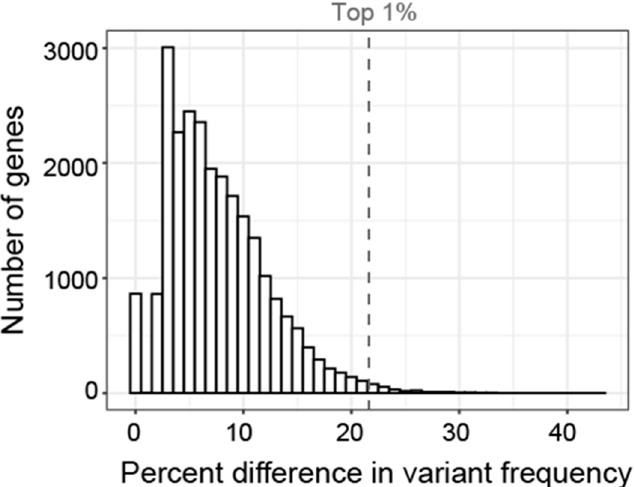
Figure 9. Histogram showing the distribution of the difference in GVF for each gene. Difference in GVF calculated as the maximum frequency minus the mean of the frequency in the other 5 subgroups. Only 1% of genes had a difference in GVF greater than 21% (gray dashed line).